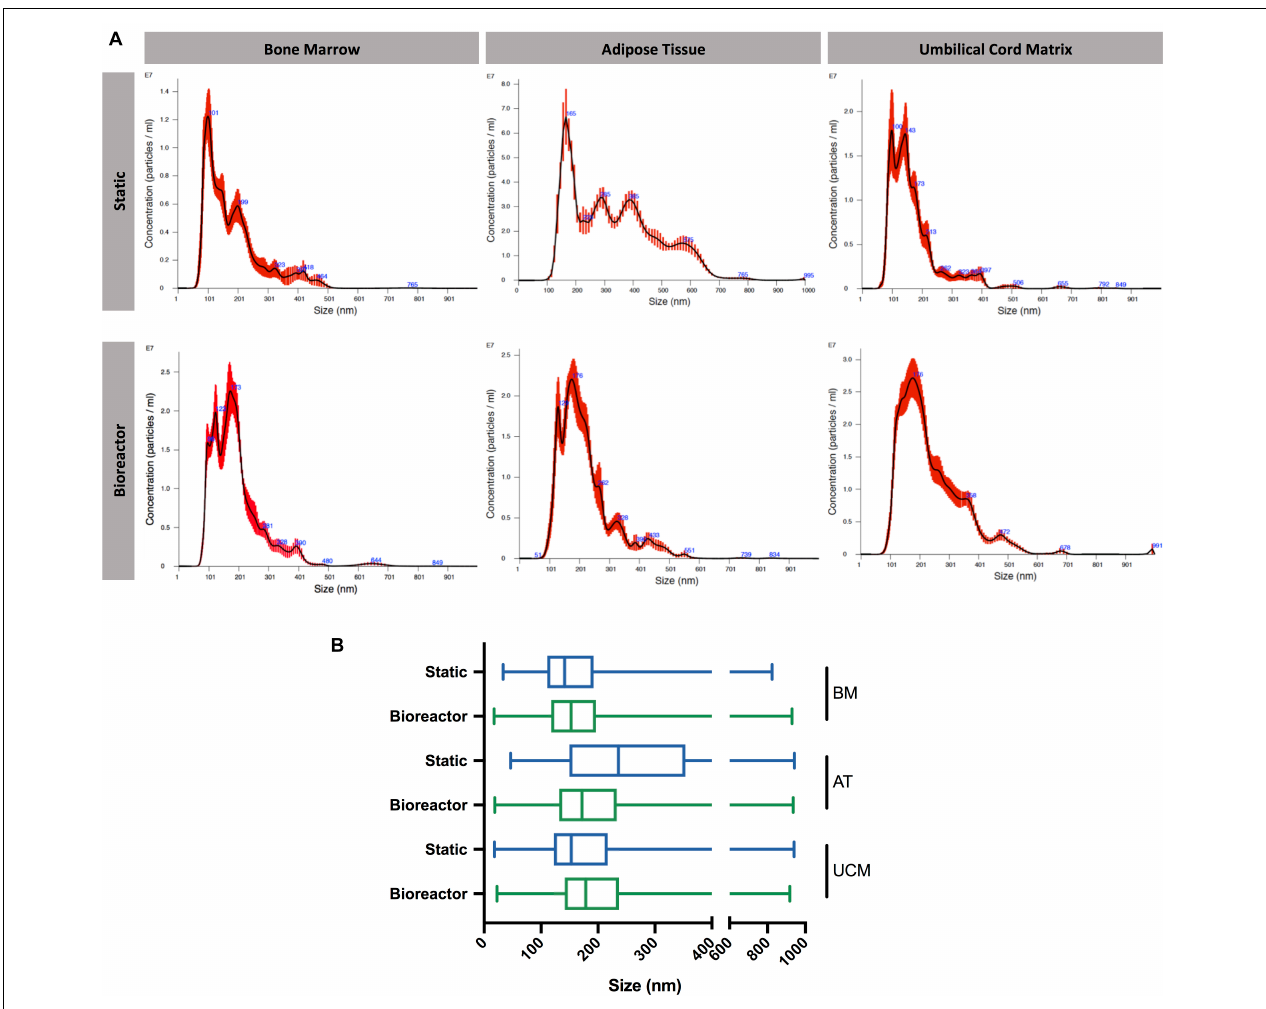
FIGURE 4 | Size distribution of MSC-EVs. (A) Representative size distribution curves of EV samples obtained from BM, AT, and UCM MSC, cultured in static or Vertical-WheelTM bioreactor systems. (B) Box plots representing the size distribution profiles of EV samples obtained from BM, AT, and UCM MSC, cultured in static or Vertical-WheelTM bioreactor systems. The minimum, 1st quartile, median, 3rd quartile and maximum values are represented for each condition. MSC from three different donors were used for each tissue source (i.e., n = 3 biological replicates). BM, bone marrow; AT, adipose tissue; UCM, umbilical cord